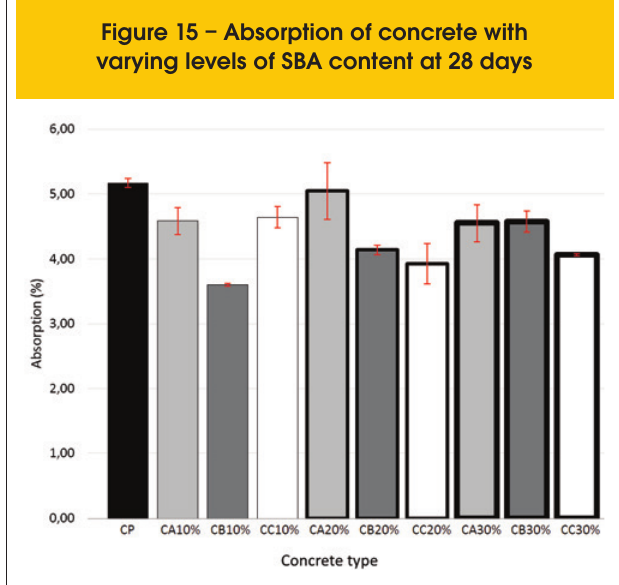
Figure 15 – Absorption of concrete with varying levels of SBA content at 28 days